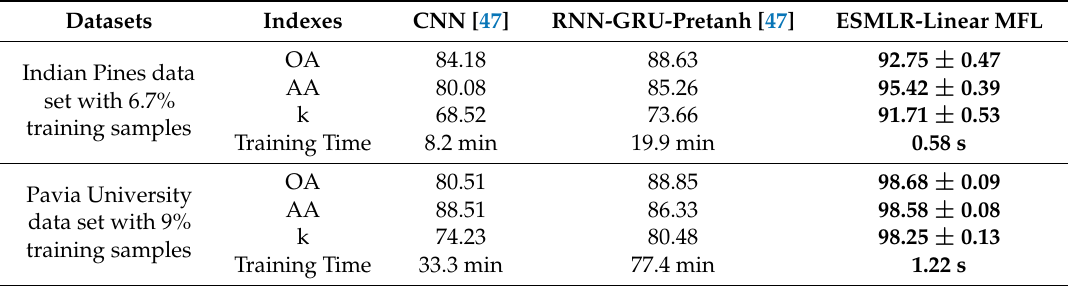
Table 5. The classification results of CNN, RNN and the proposed method. The best accuracy/least training time in each row is shown in